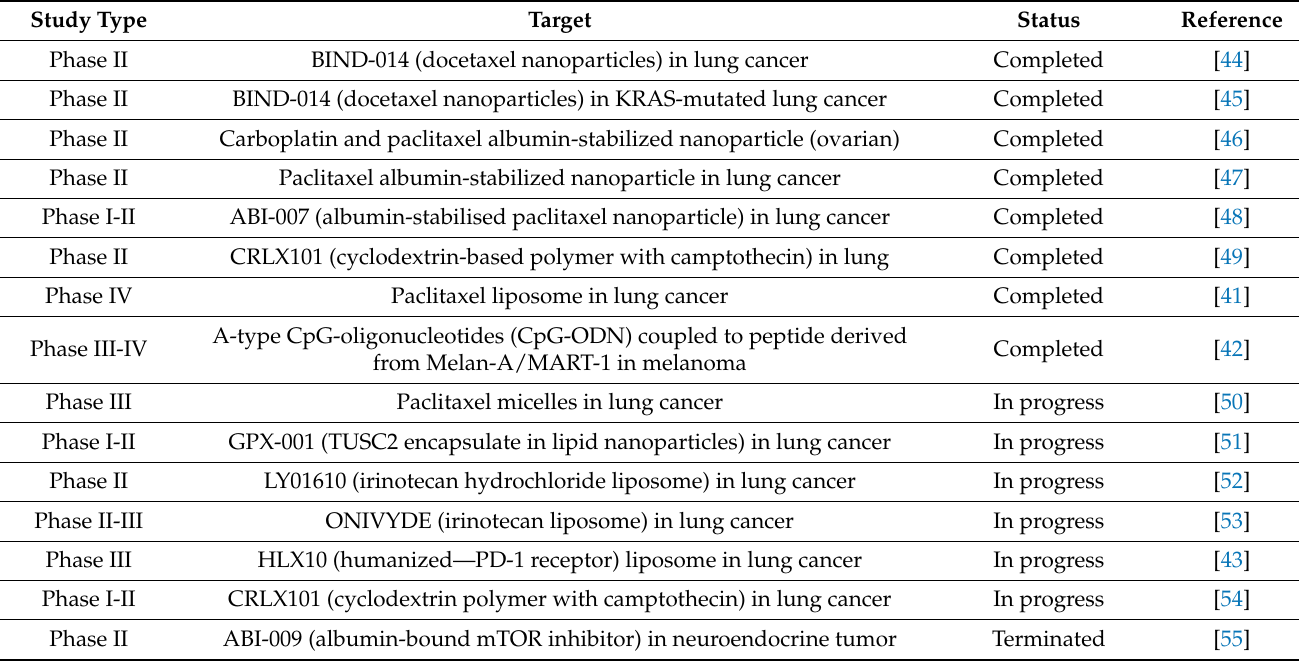
Table 4. Clinical trials with lipid nanoparticles in solid